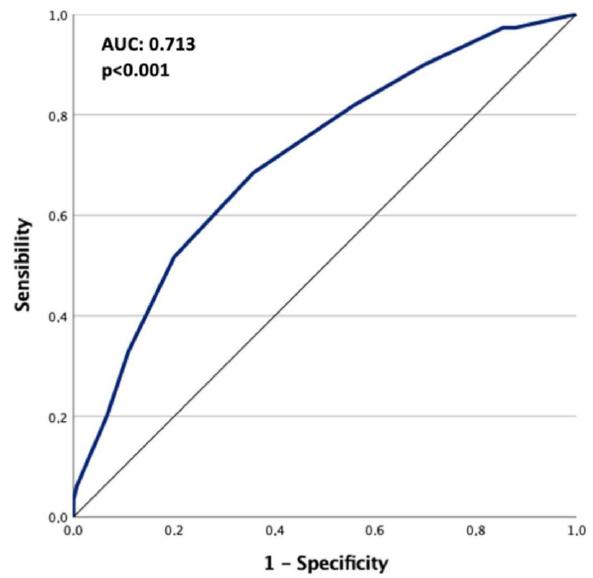
Figure 4. ROC curve for the diagnostic accuracy of the ASCL score in predicting P/F. Ratio deteriora- tion below